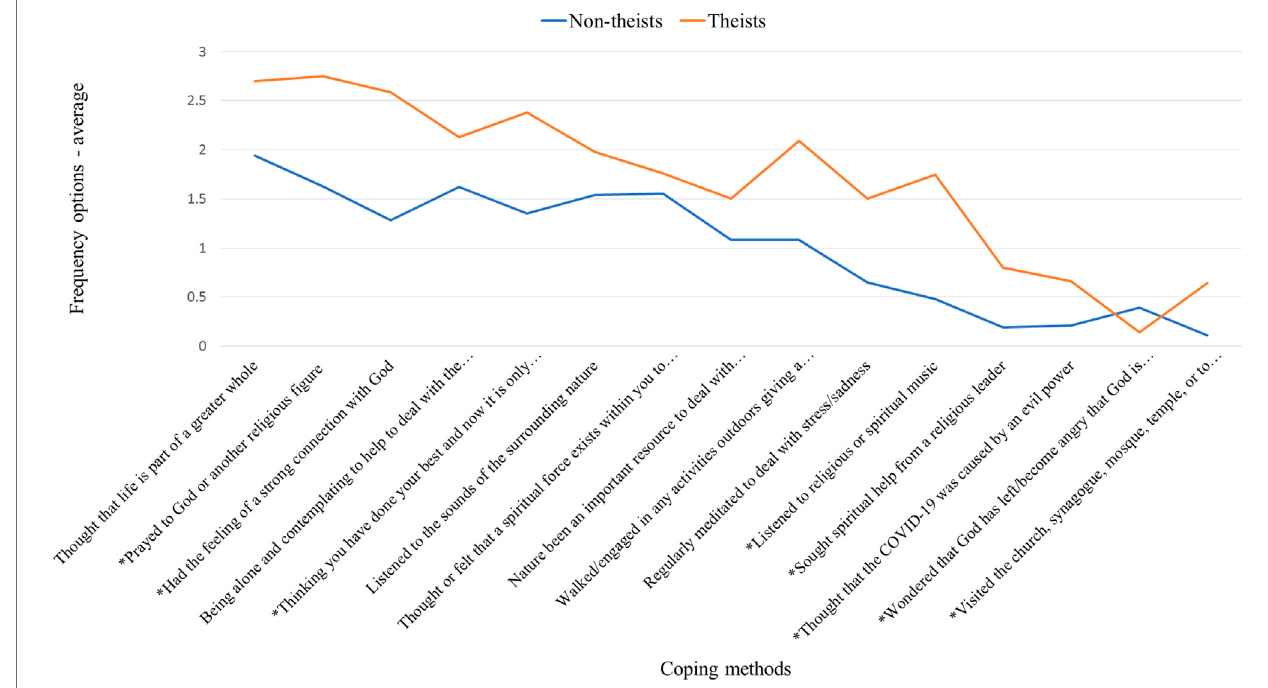
FIGURE 6 | Two auto-generated segments based on frequency of use of different coping